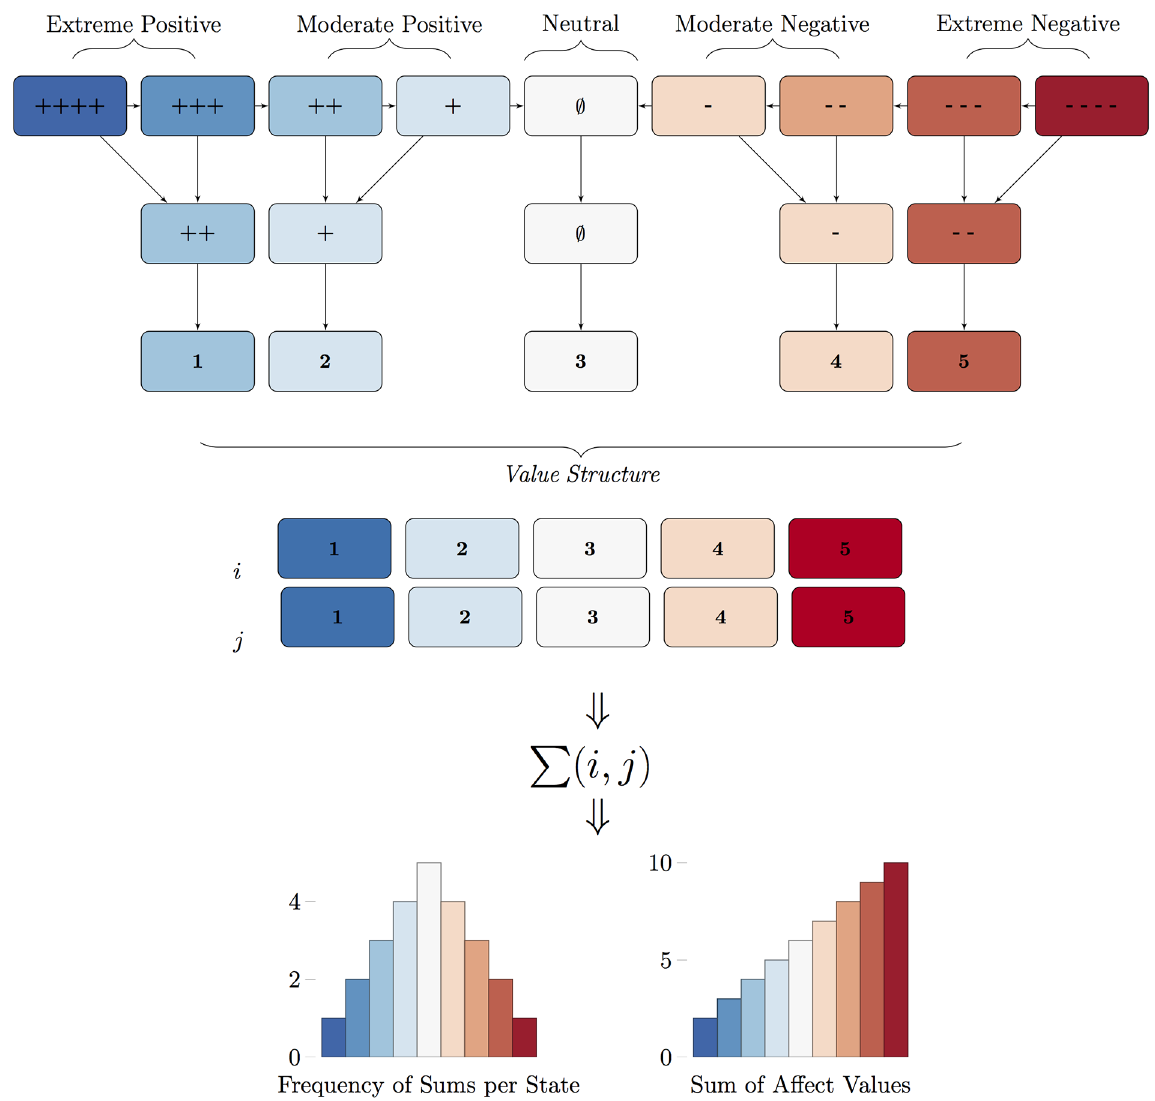
Fig 2. States Data Reduction Scheme. Original categories are shown at the top; these were collapsed and summed within dyad. Profiles of possible frequencies and summed values are shown at the bottom, left and right,